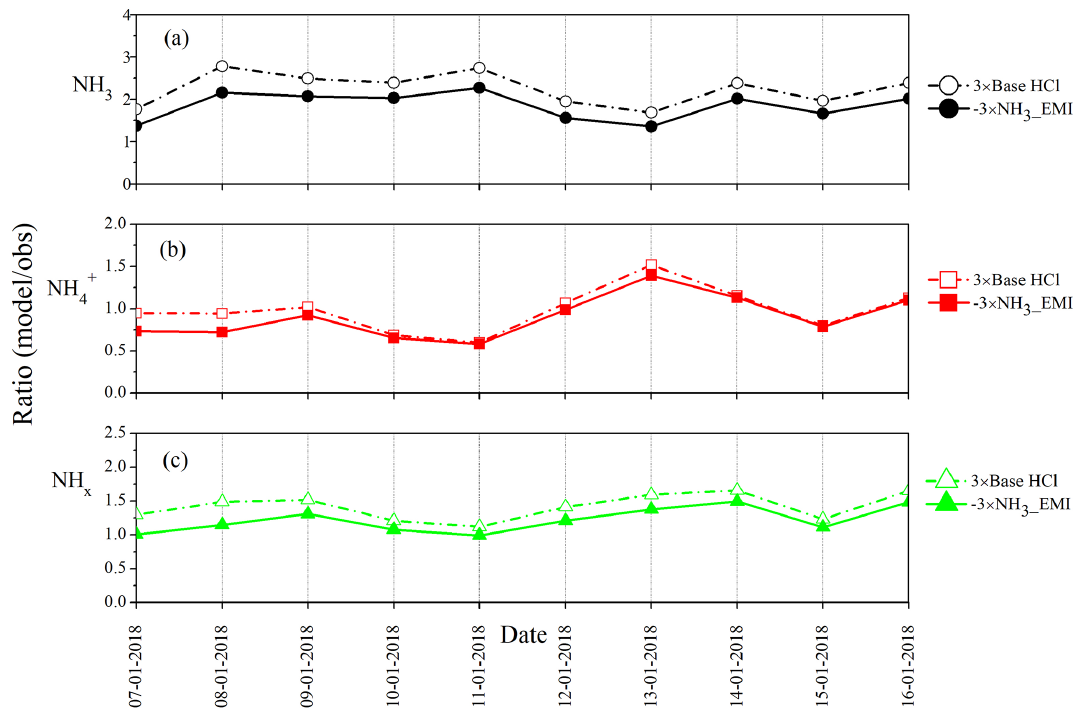
+ concentration, and (c) total NH x concen- 4